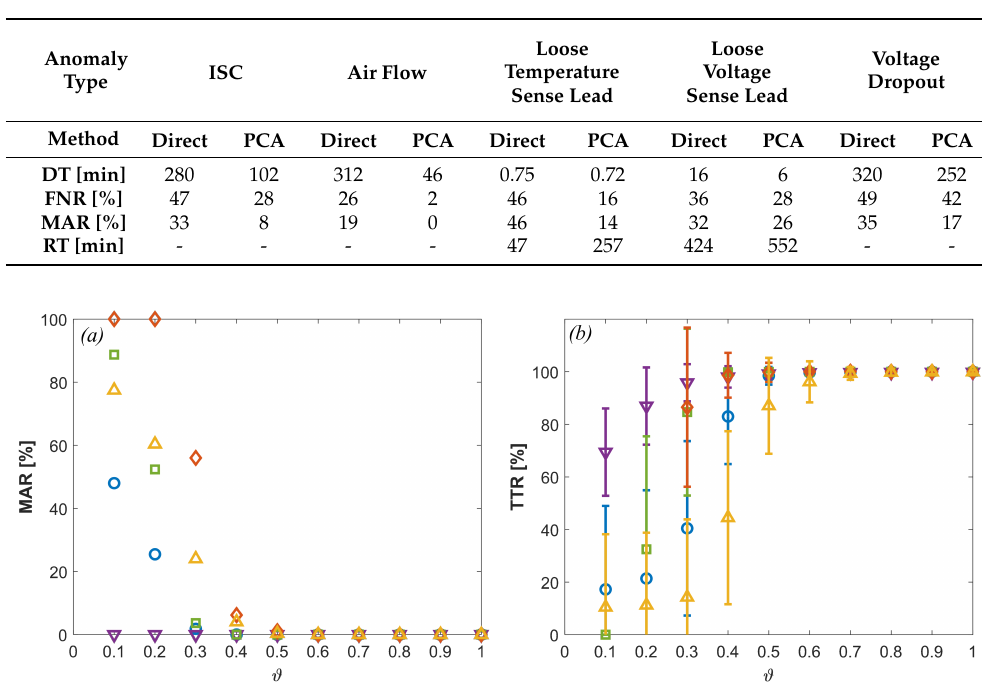
Table 2. Average performance indices from statistical testing.